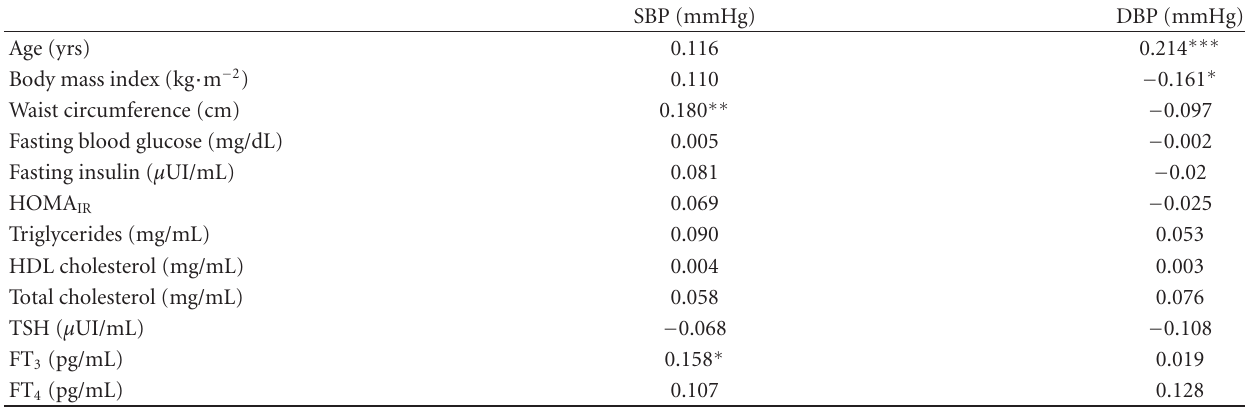
Table 2: Pearson correlation coe ffi cients of 24-h mean systolic (SBP) and 24-h mean diastolic blood pressure (DBP) with general, anthro- pometric, metabolic variables in subjects under study ( n = 231).